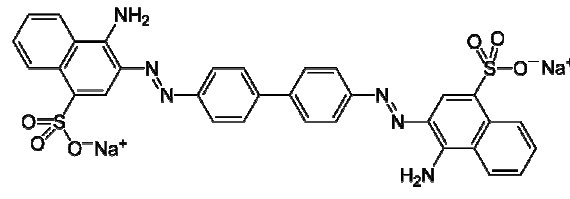
Figure 1 Chemical structure of Congo